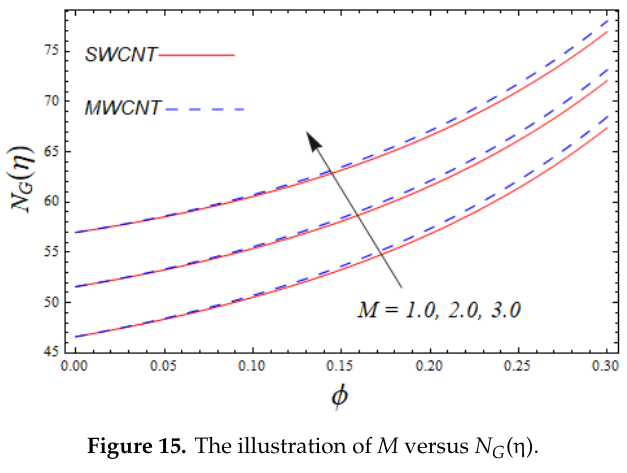
Figure 14. The illustration of B r versus N G (η).